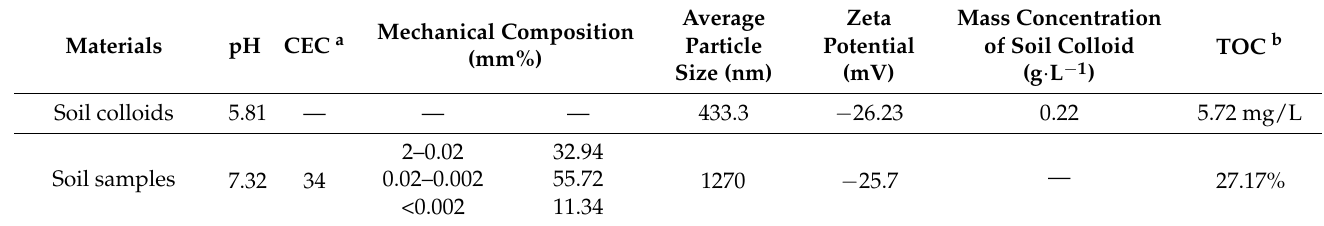
Table 1. The basic physicochemical characteristics of soil samples and soil colloids.